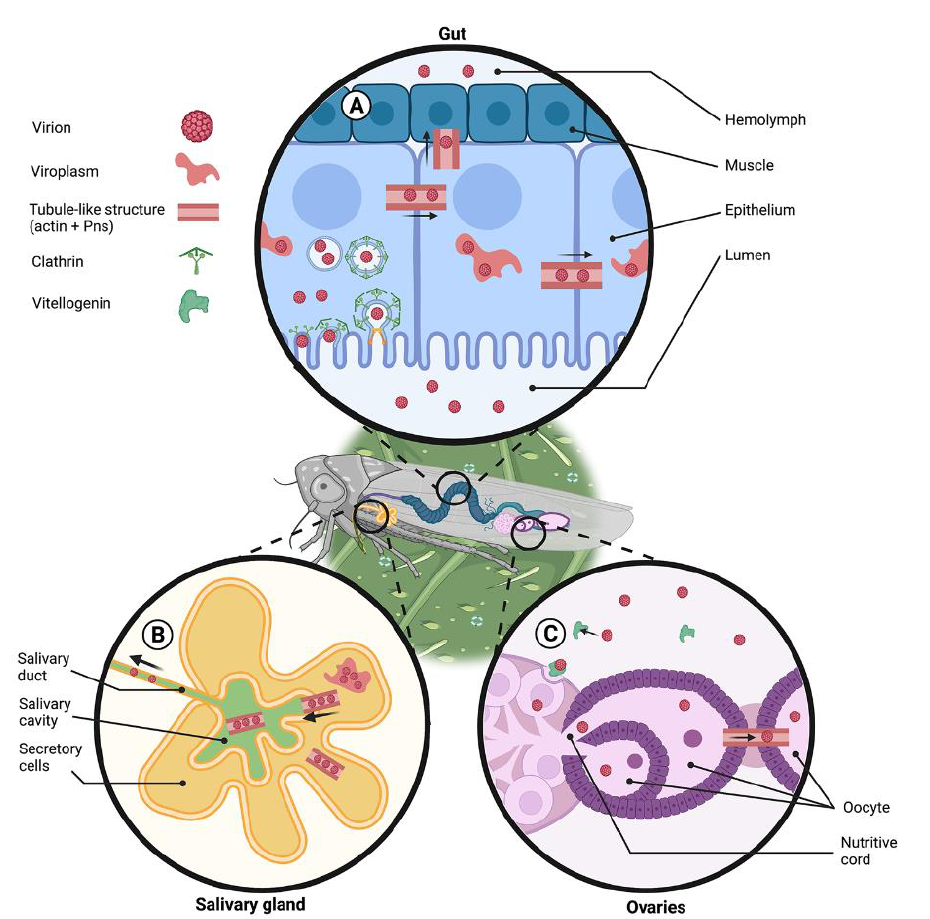
Figure 3 . Reovirus infection cycle in the insect vector. Virions should breach three major tissue bar- riers: insect gut for their dissemination throughout the insect body ( A ), salivary glands for